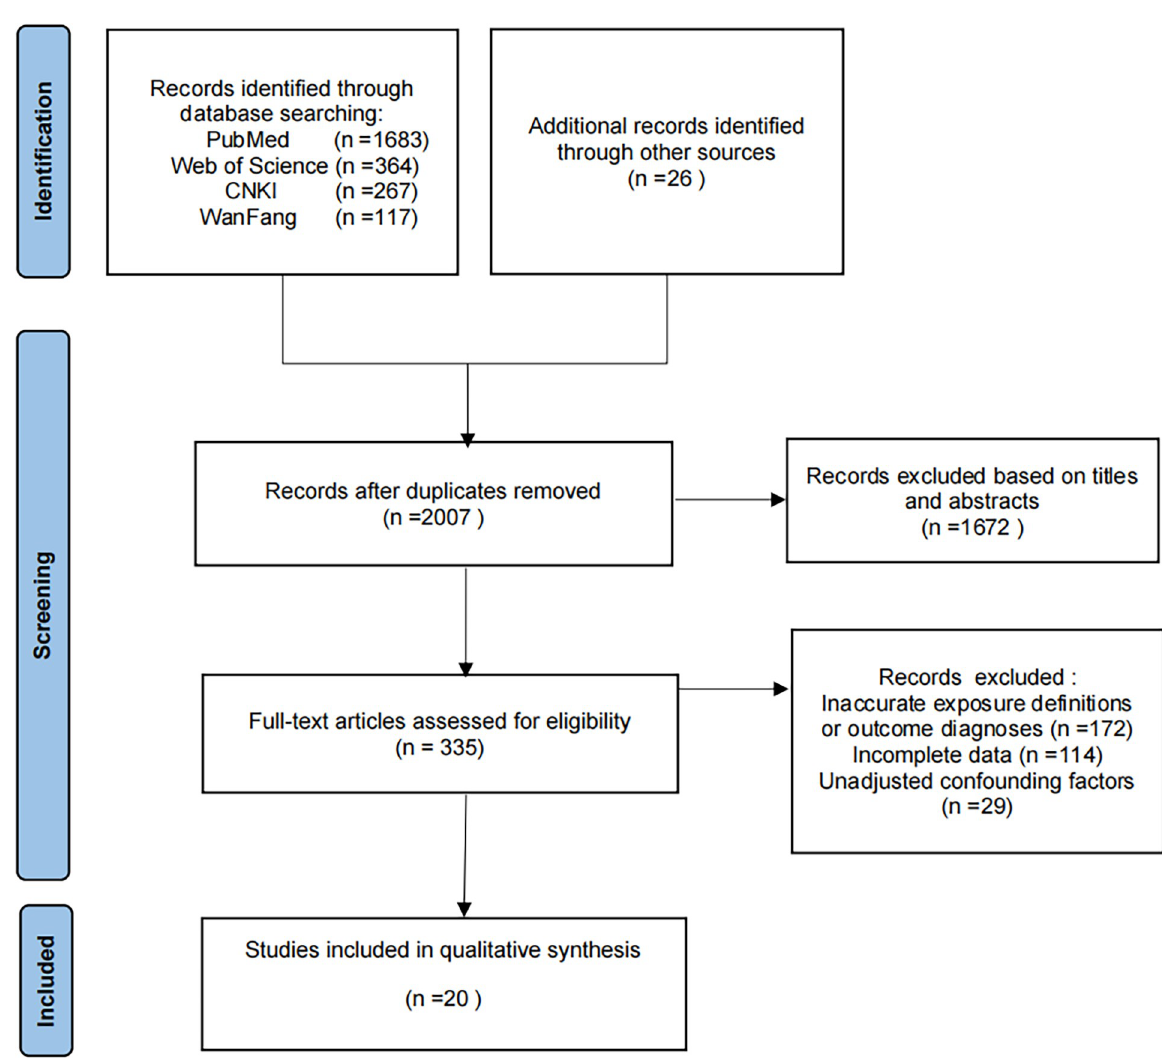
Fig 1. PRISMA flow diagram for selection of